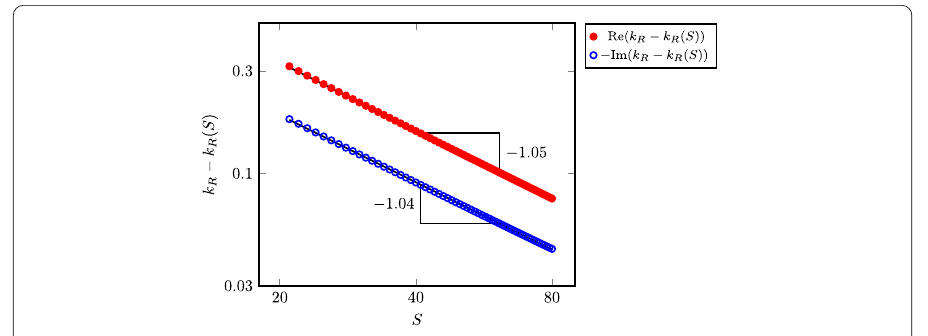
Figure 5 Convergence of the real and imaginary parts of the approximated Rayleigh conductivity k R ( S ) to its limit value k R = 4.513 – 1.210 ı in dependence of the truncation radius S for the liner DC006 at frequency f = 306 Hz (see Table 1)